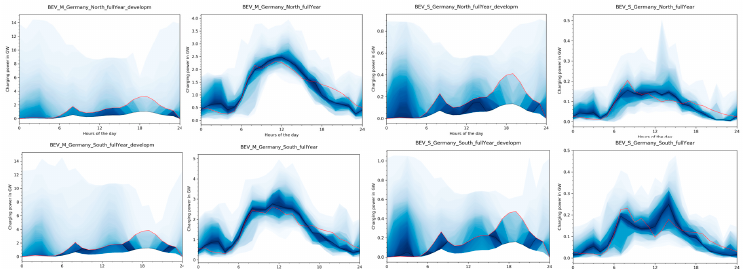
Figure A4. Daily probability distributions for total charging (controlled and uncontrolled) of medium and small sized BEV fleets in Northern Germany (top row) and Southern Germany (bottom row). The first and the third column show S1 results and the second and third column show S2 results. A case of completely uncontrolled charging is shown as red line.